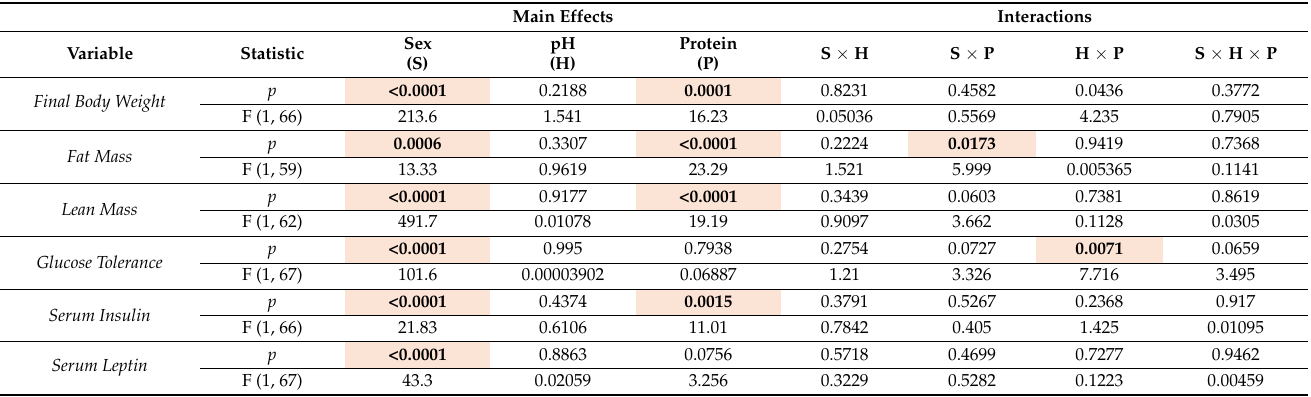
Table 3. Effects of sex, pH, and protein in on body weight and body composition, glucose tolerance and serum markers in low fat (LF) diet-fed B6 mice. p and F values of three-way ANOVA to evaluate main effect and interactions.